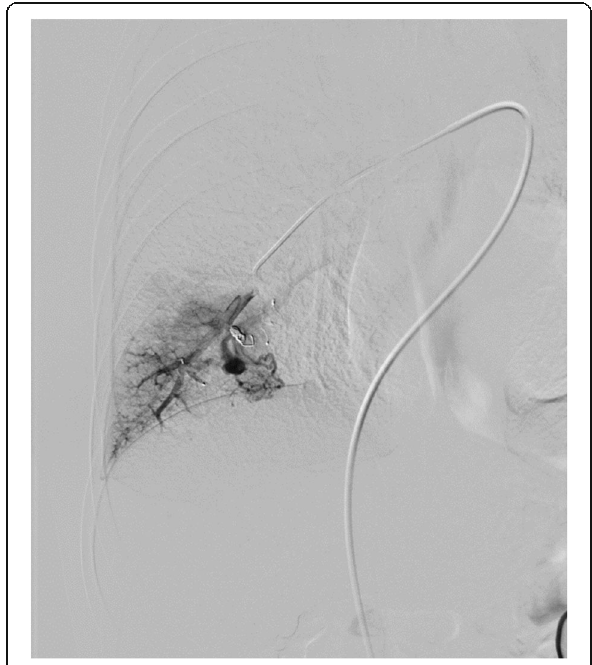
Fig. 8 The PAVM in lower lobe was embolized with detachable coil and with